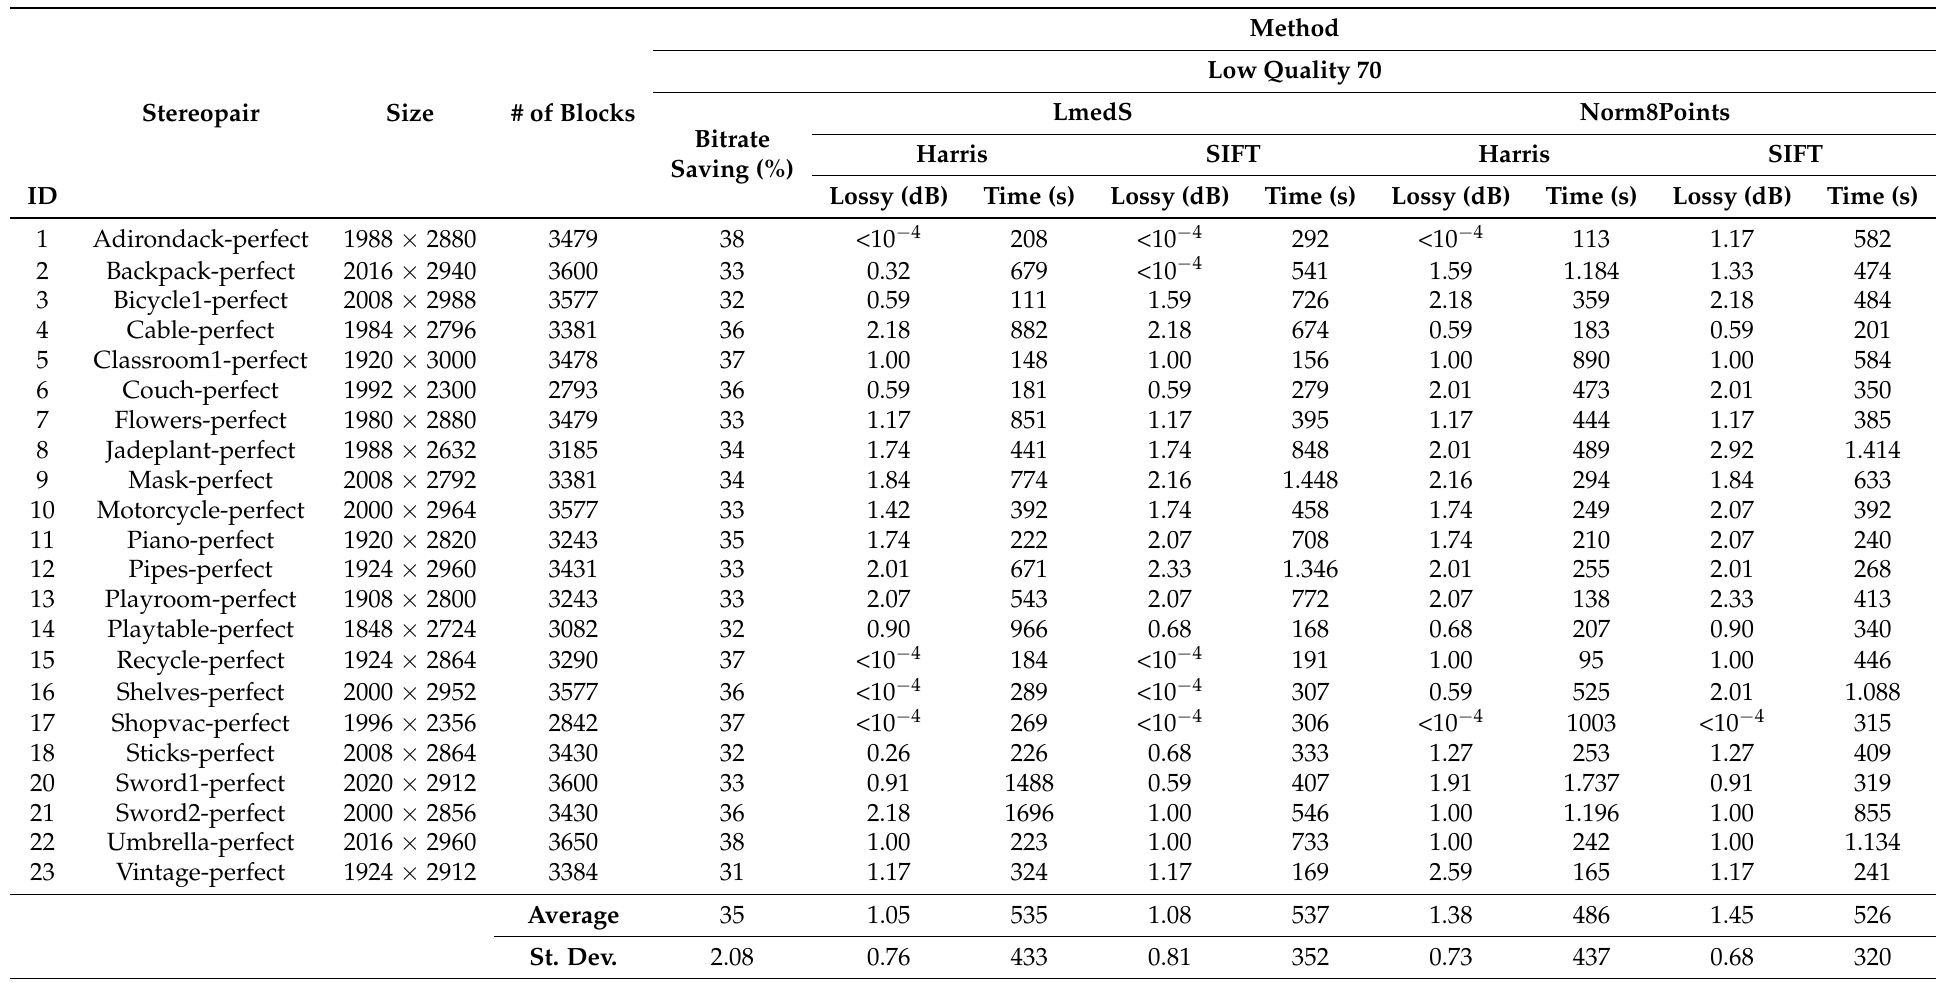
Table 3. Results on the middlebury-scenes 2014 dataset, considering a low quality of